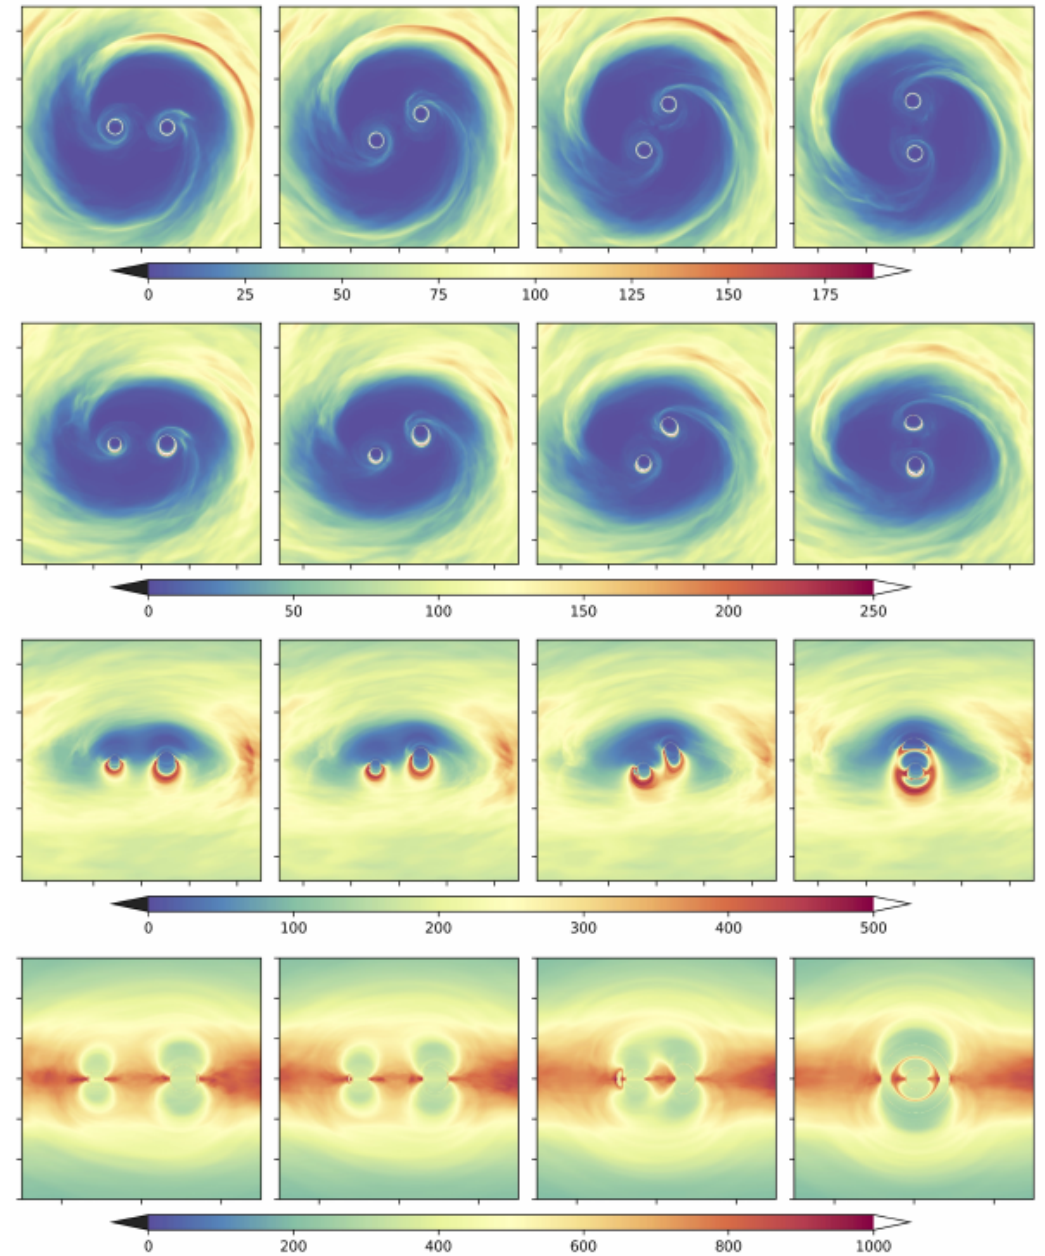
Figure 3. Images of optical depth obtained by properly tracing light rays through the spacetime for different times (columns) from circumbinary accretion around supermassive black holes from [74] for inclination angles 0 ◦ , 39 ◦ , 71 ◦ , 90 ◦ (from top to bottom row). Strong lensing effects introducing complicated image distortions are clearly